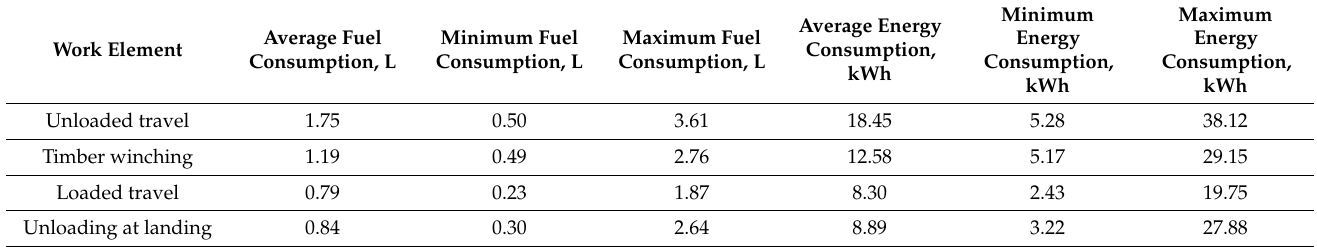
Table 5. Average fuel and energy consumption of the skidder by work element.